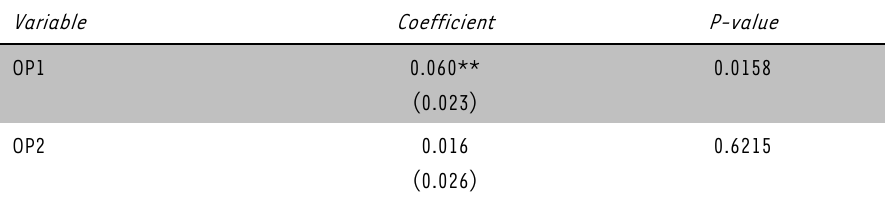
TABLE 6: Oil Prices and Economic Activity Regression: Decomposed Data